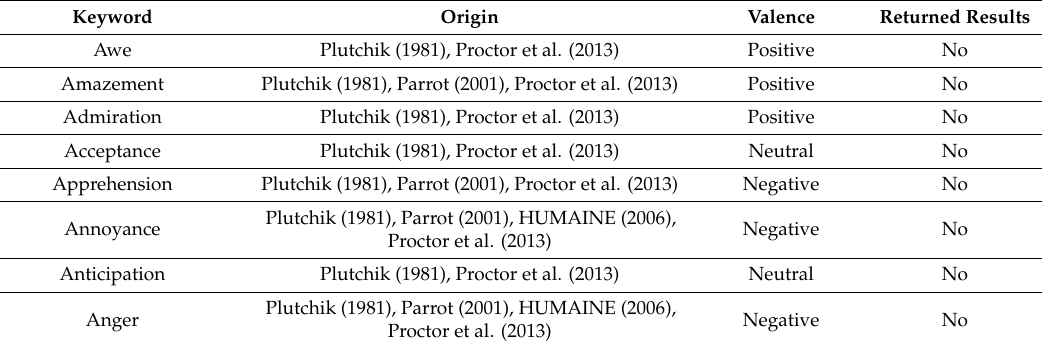
Table A1. The keywords used in the study, including details of their source, valence and whether they returned suitable